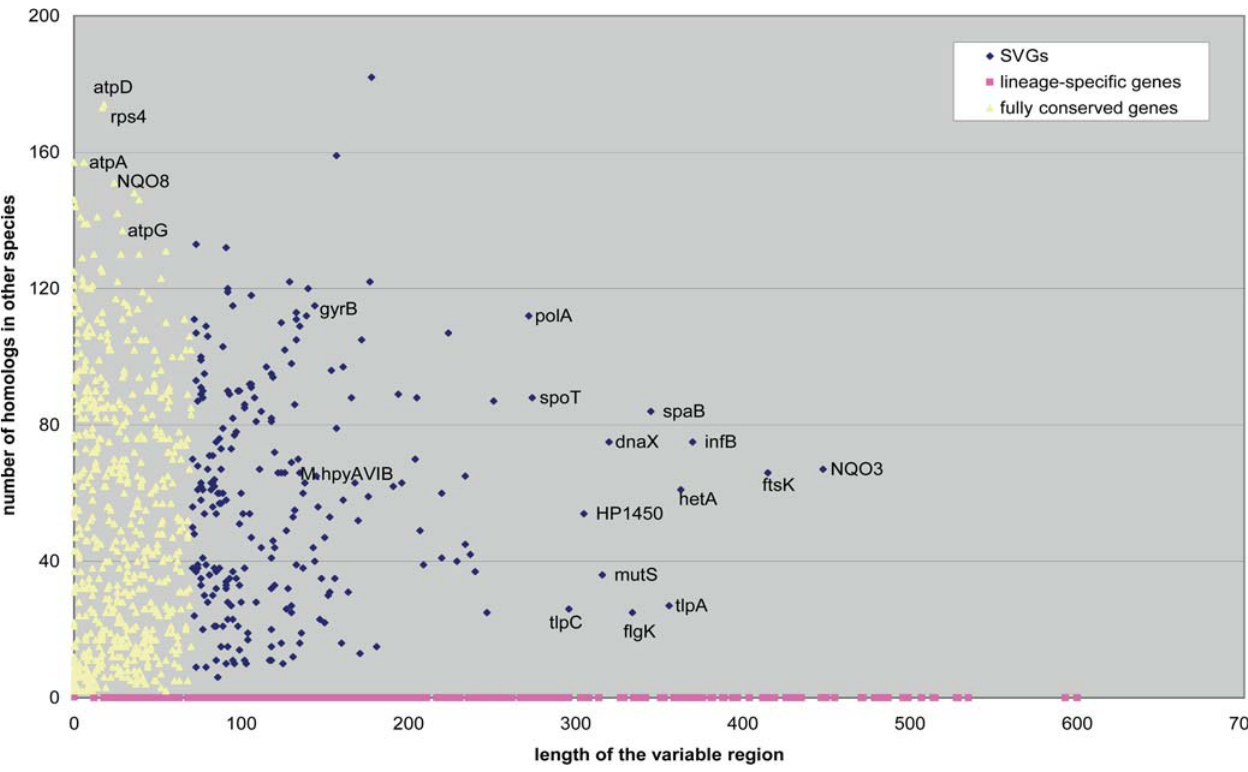
Figure 2. Classification of Three Groups of Genes from a Single Genome, H. pylori , in 2D Space The x-axis is the length of the variable region and the y-axis is the number of possible homologs a gene has from a BLAST search. The variable region length for a lineage-specific gene is defined as the length of the gene so that they naturally cluster onto the x-axis. Multiple variable regions in one gene are represented separately. DOI: